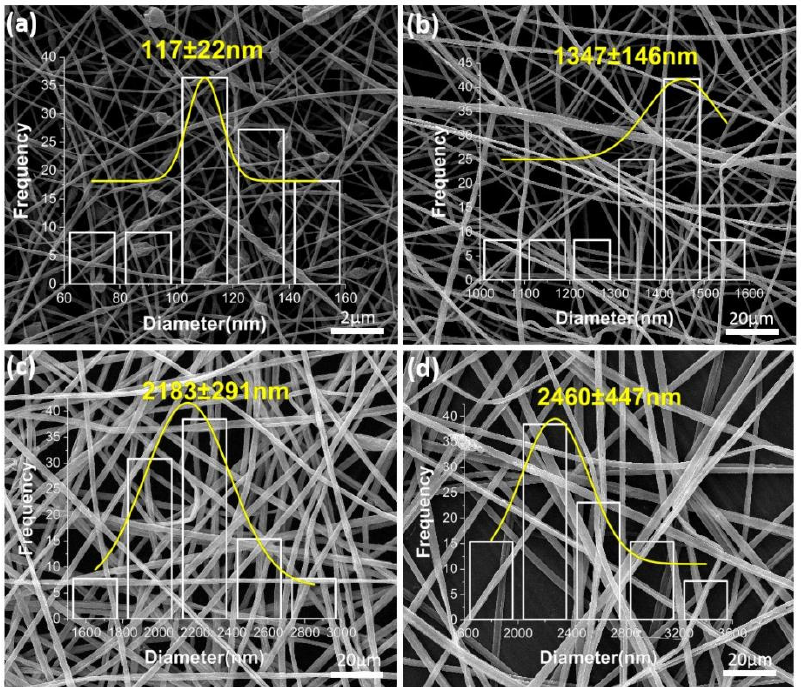
Figure 4. SEM images of the active-substance-loaded electrospun ultrathin fibers: ( a ) F3—zein- AgNP uniaxial nanofiber; ( b ) F4—PEO(core)/zein-AgNPs(sheath) coaxial nanofiber; ( c ) F5—PEO- RE(core)/zein-AgNP(sheath) coaxial nanofiber; ( d ) F6—PEO-RE(core)/zein-AgNP-RE(sheath) coax- ial nanofiber.